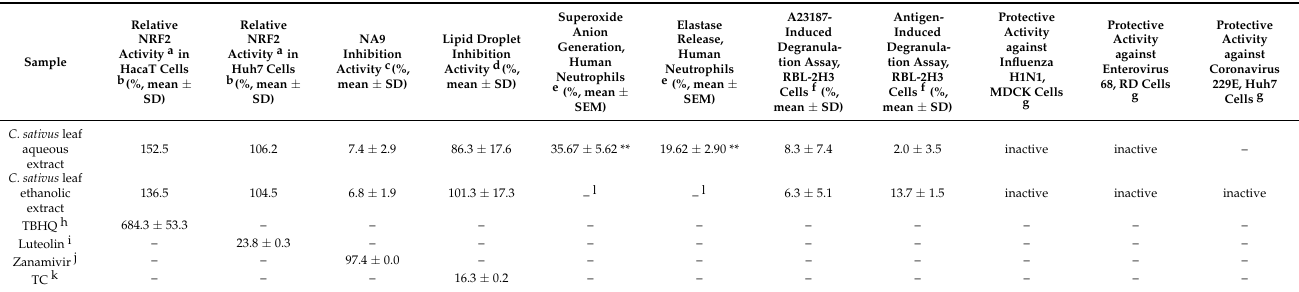
Table 5. Neuraminidase (NA) and lipid droplets activity